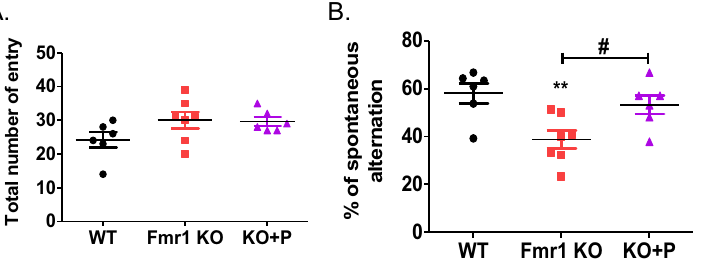
Figure 4. Restored spatial memory and learning ability in Fmr1 knockout mice with pirenperone treatment. Y-maze was performed at the age of 6 weeks by measuring ( A ) total number entry for 8 min recording. ( B ) percent of spontaneous alternation by calculating [(number of alternation/total number of entry − 2) × 100]. One-way ANOVA, post hoc test: Bonferroni’s multiple comparison test, WT versus Fmr1 KO, ** p < 0.01, Fmr1 KO versus KO + P (pirenperone), # p < 0.05 (Number of samples per group = 6–7).